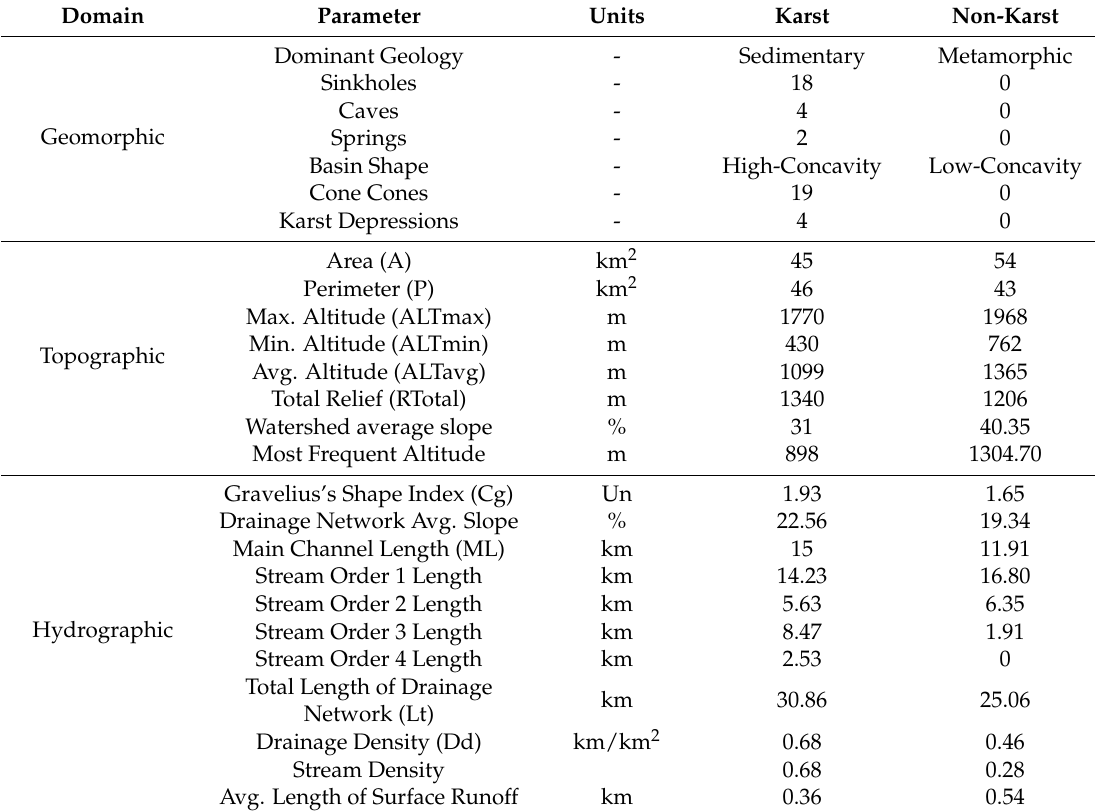
Figure 8. 3D Geomorphometric illustration ( A ) Miaogou watershed characterized by an elongated shape with the presence of spring, sinkholes, caves, karst depressions and karst cones ( B ) Gaojiaping watershed characterized by a broader fan-shaped area with no karst features. Table 1. Summary of parameters for both Miaogou (karst) and Gaojiaping (Non-karst) watersheds.